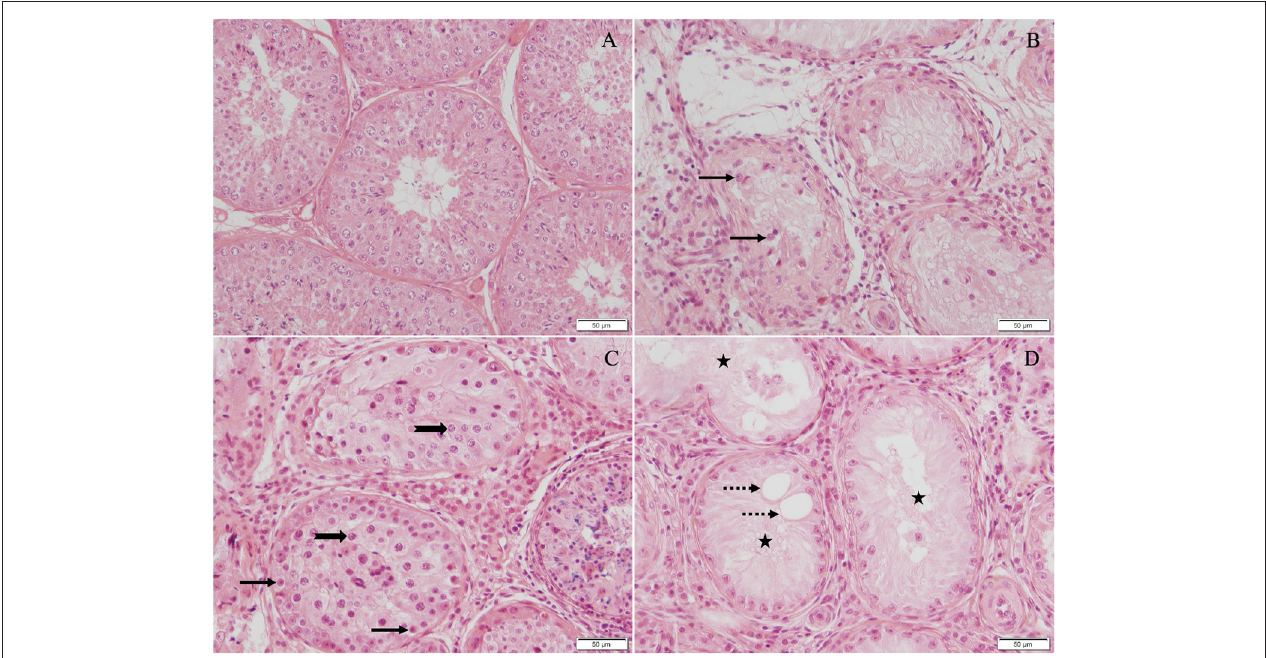
FIGURE 2 | Haematoxylin–eosin-stained testicular tissue (200 × magnification): (A) Normospermic dogs with unaltered spermatogenesis served as control group, (B) early arrest with germ cell development arrested at stage of spermatogonia ( black arrow ), (C) late arrest with germ cell development arrested at stage of spermatocytes ( thick black arrow ), round, elongating, or elongated spermatids, and (D) Sertoli-cell-only syndrome with germ cells completely lacking ( black star ), and vacuoles are present in seminiferous tubules ( dotted arrow ). Fibrosis and massive immune-cell infiltration indicate presence of immune-related orchitis in all cases of NOA (B – D) .